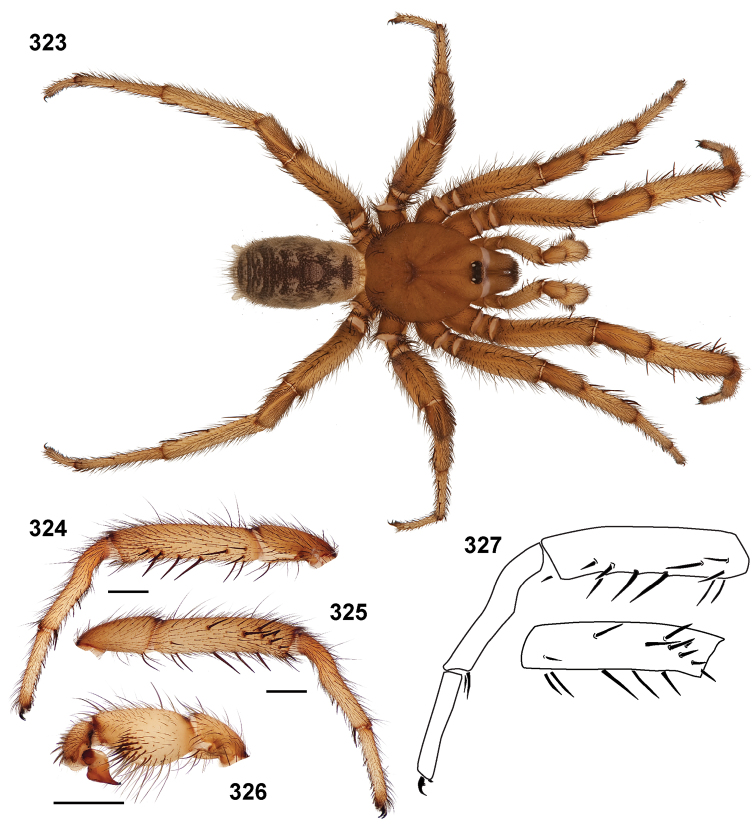
Aptostichus cajalco sp. n. male holotype (MY3778) from Riverside County; scale bars = 1.0mm. 323 habitus [806393] 324 retrolateral aspect, leg I [806395] 325 prolateral aspect, leg I [806397] 326 retrolateral aspect, pedipalp [806399] 327 line drawings of leg I spination pattern; retrolateral aspect, tibia, metatarsus, tarsus; tibia.